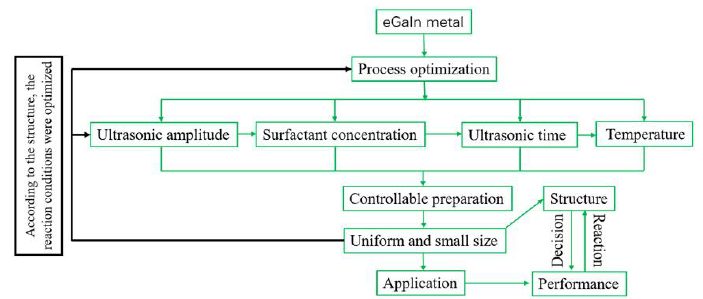
Figure 2. Schematic plot for the synthesis strategy of eGaIn nanodroplets.